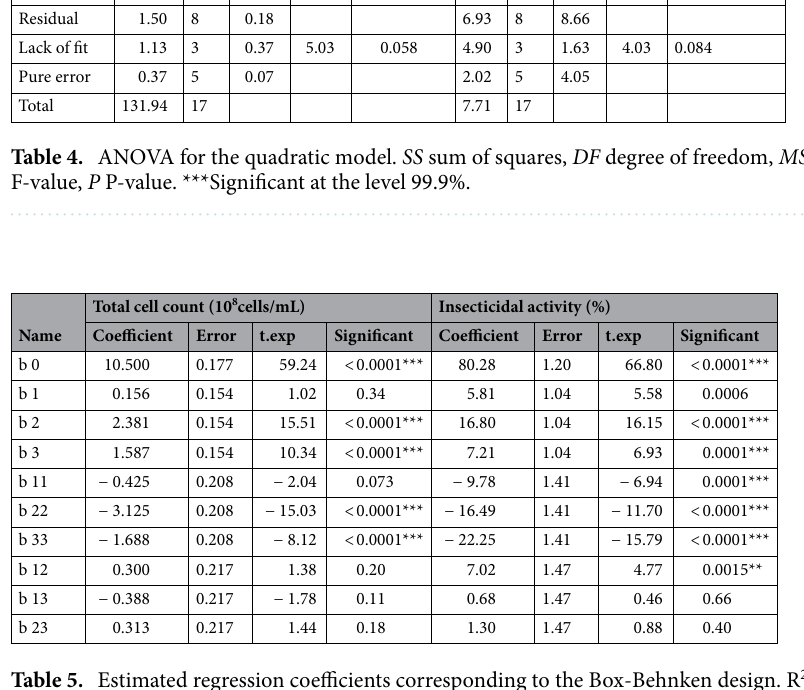
Table 5. Estimated regression coefficients corresponding to the Box-Behnken design. R 2 (Y 1 ) = 0.989; Adj R 2 (Y 1 ) = 0.976; R 2 (Y 2 ) = 0.991; Adj R 2 (Y 2 ) = 0.981. ***Significant at the level 99.9%. **Significant at the level